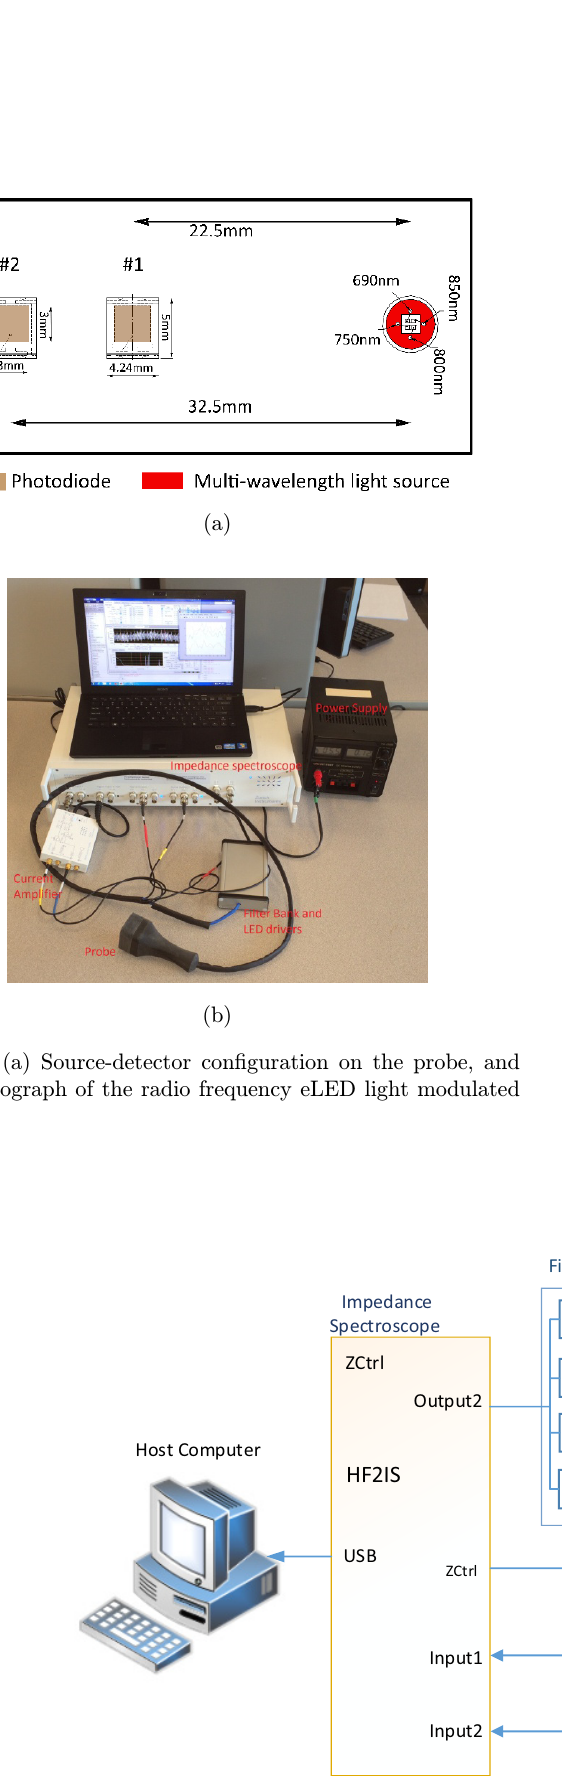
Fig. 2. Schematic block diagram of the